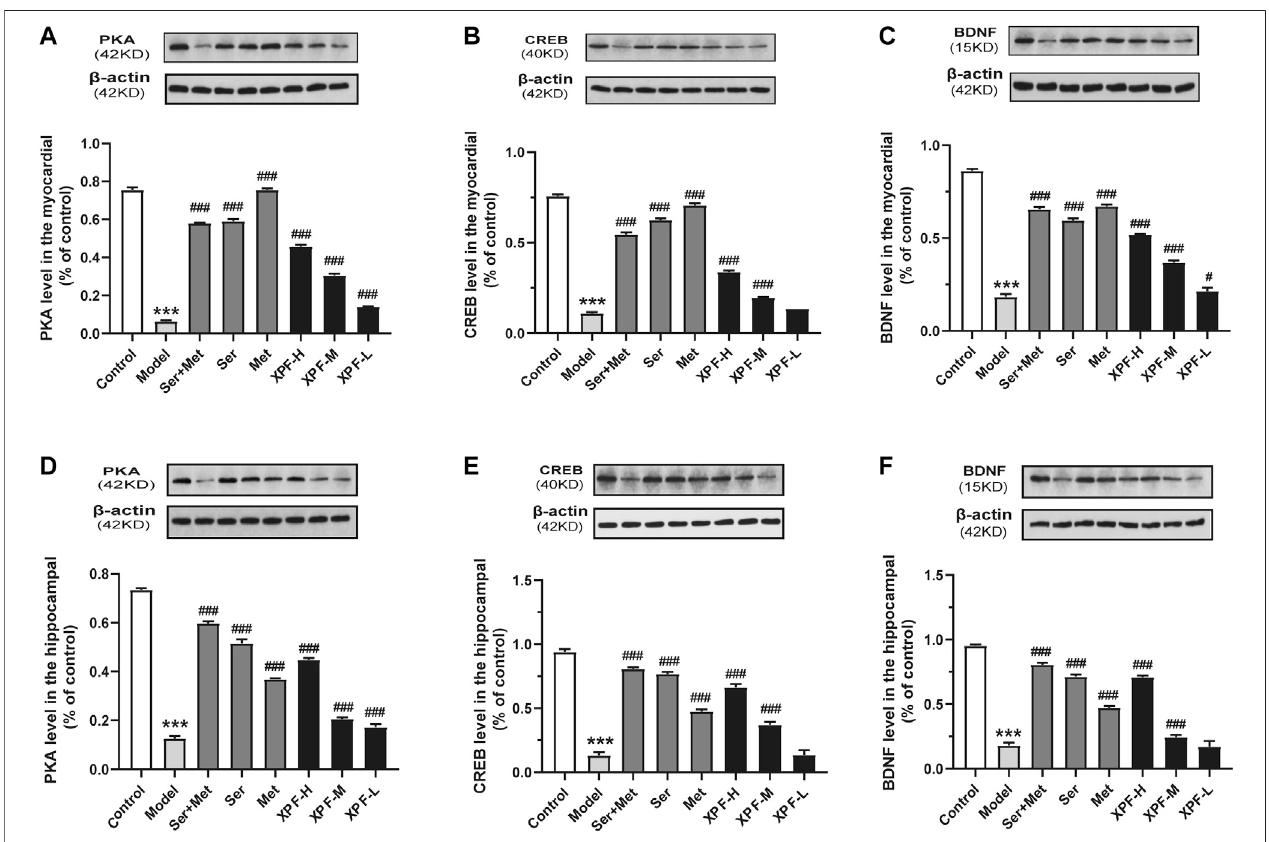
FIGURE7| Experimental validationofkeytargetsPKA,CREB,BDNFinratmyocardiumand hippocampus inducedbyCUMSandISO. (A) Quantitative analysisof PKA expression inthe myocardial. (B) Quantitative analysisofCREB expression in themyocardial. (C) Quantitative analysisofBDNF expression inthe hippocampal. (D) Quantitative analysis of PKA expression in the hippocampal. (E) Quantitative analysis of CREB expression in the hippocampal. (F) Quantitative analysis of CREB expression in the hippocampal. Data were presented as means ± SD ( n (cid:2) 3). *** p < 0.005 compared with the control group, ## p < 0.01, ## p < 0.005.